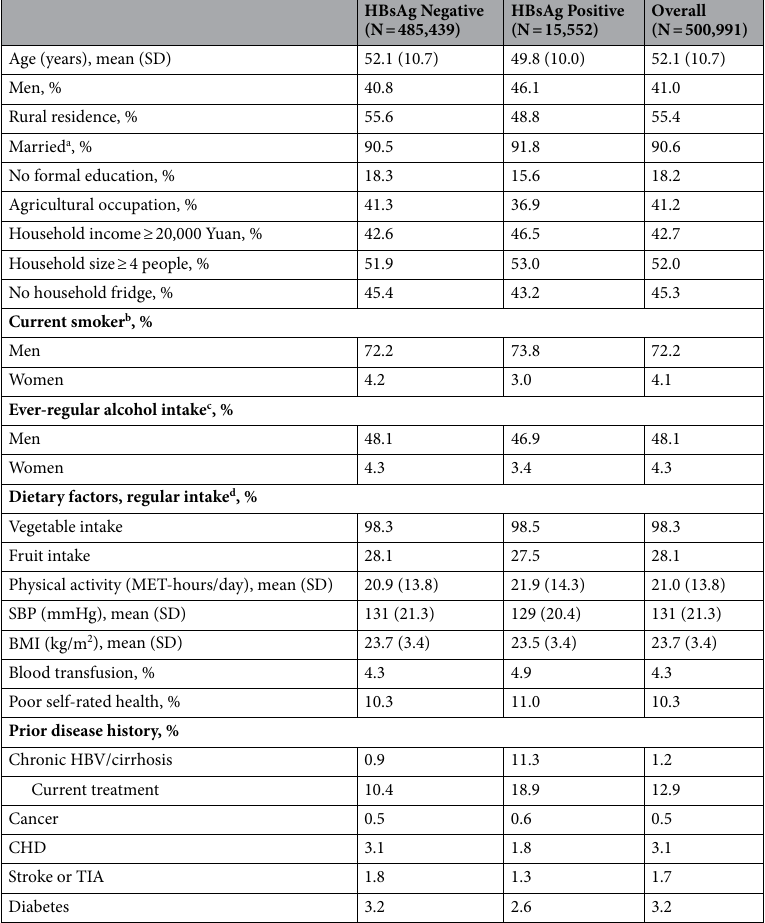
Table 1. Baseline characteristics of overall cohort and by Hepatitis B surface antigen status. HBsAg, hepatitis B surface antigen; MET, metabolic equivalent of task; SBP, systolic blood pressure; BMI, body mass index; CHD, coronary heart disease; TIA, transient ischaemic attack. a Married: Participants who reported currently being married, b Smoking: Current smoker includes those reportingoccasional or current smoking, c